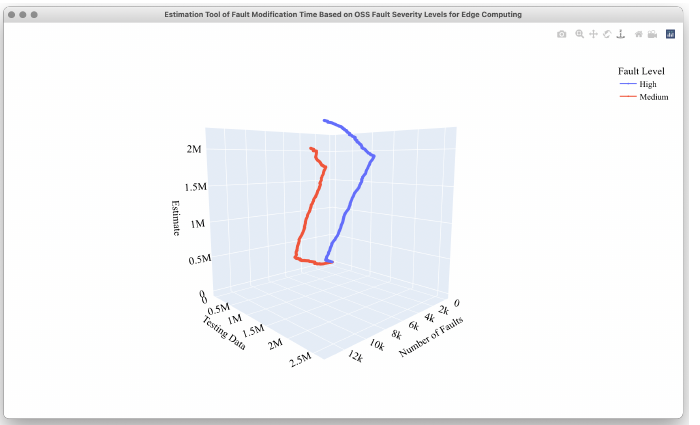
Figure 16. The estimated fault correction time in case of medium-level 30% testing data.